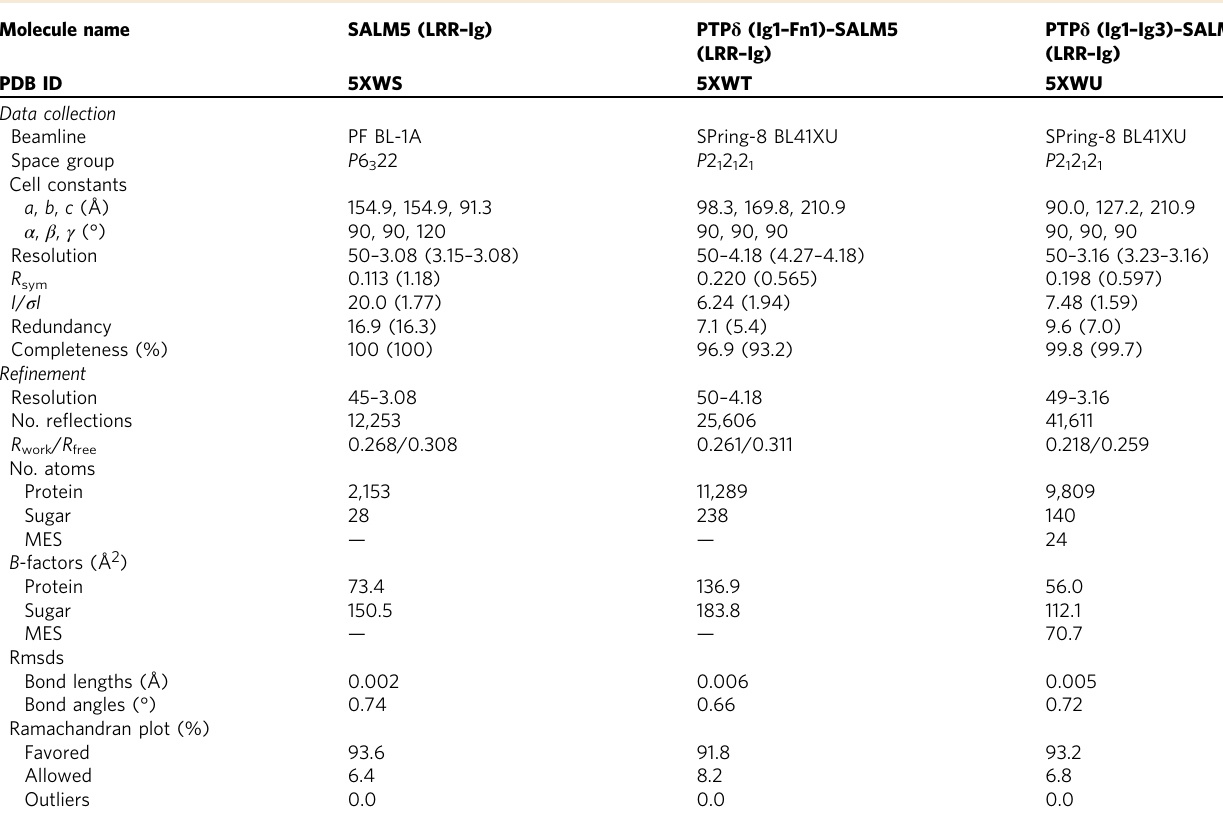
Table 1 Data collection and re fi nement